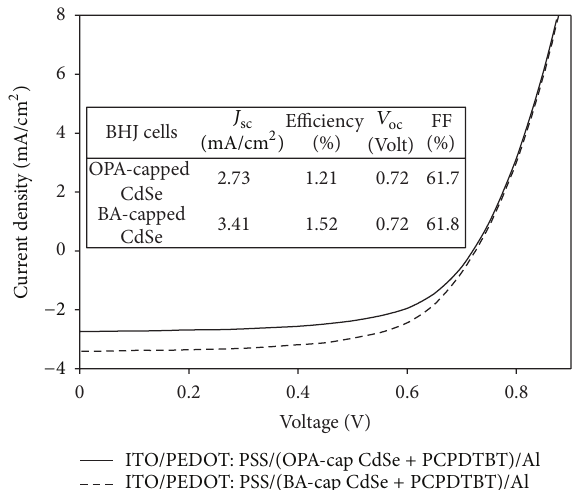
Figure 7: 𝐽 - 𝑉 curves for the devices with OPA-capped and butylamine-capped CdSe tetrapod nanocrystals (CdSe/[CdSe+ PCPDTBT] =